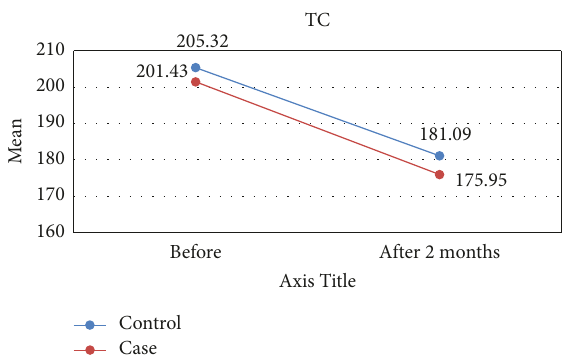
Figure 7: Effect of lycopene supplementation on SBP levels.